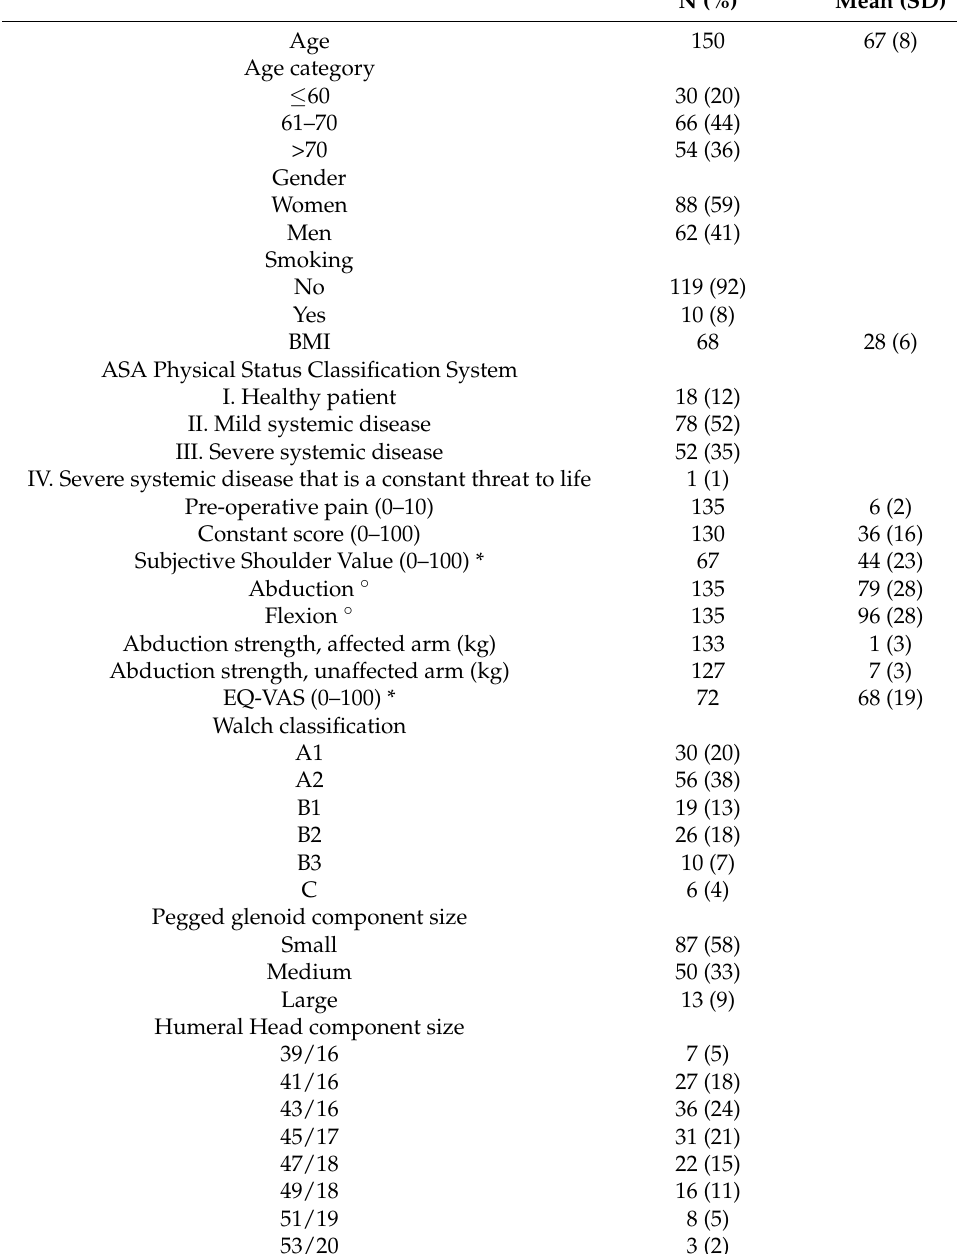
Table 1. Baseline